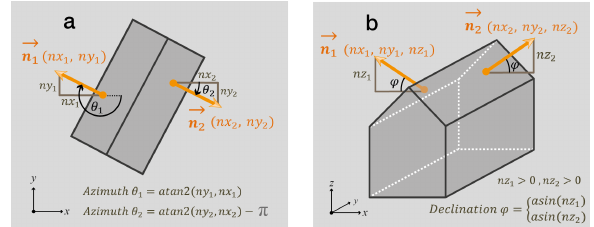
Figure 3. Roof model surflets of gabled roof. Roof properties are reflected by using surflet pairs (orange). a): The horizontality of ridges is represented by the fact that the azimuths θ 1 and θ 2 of the normals (cid:126)n 1 and (cid:126)n 2 of the surflets differ in exactly π . Symmetric gabled roof: The declination ϕ must be identical